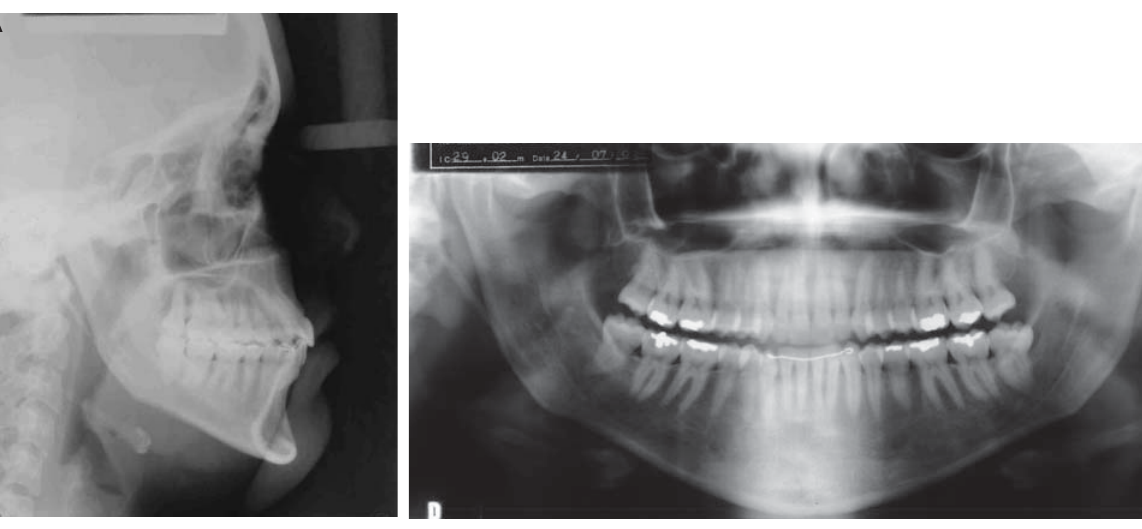
Figure 9- Lateral cephalograms (A) and panoramic radiograph (B) 14-year